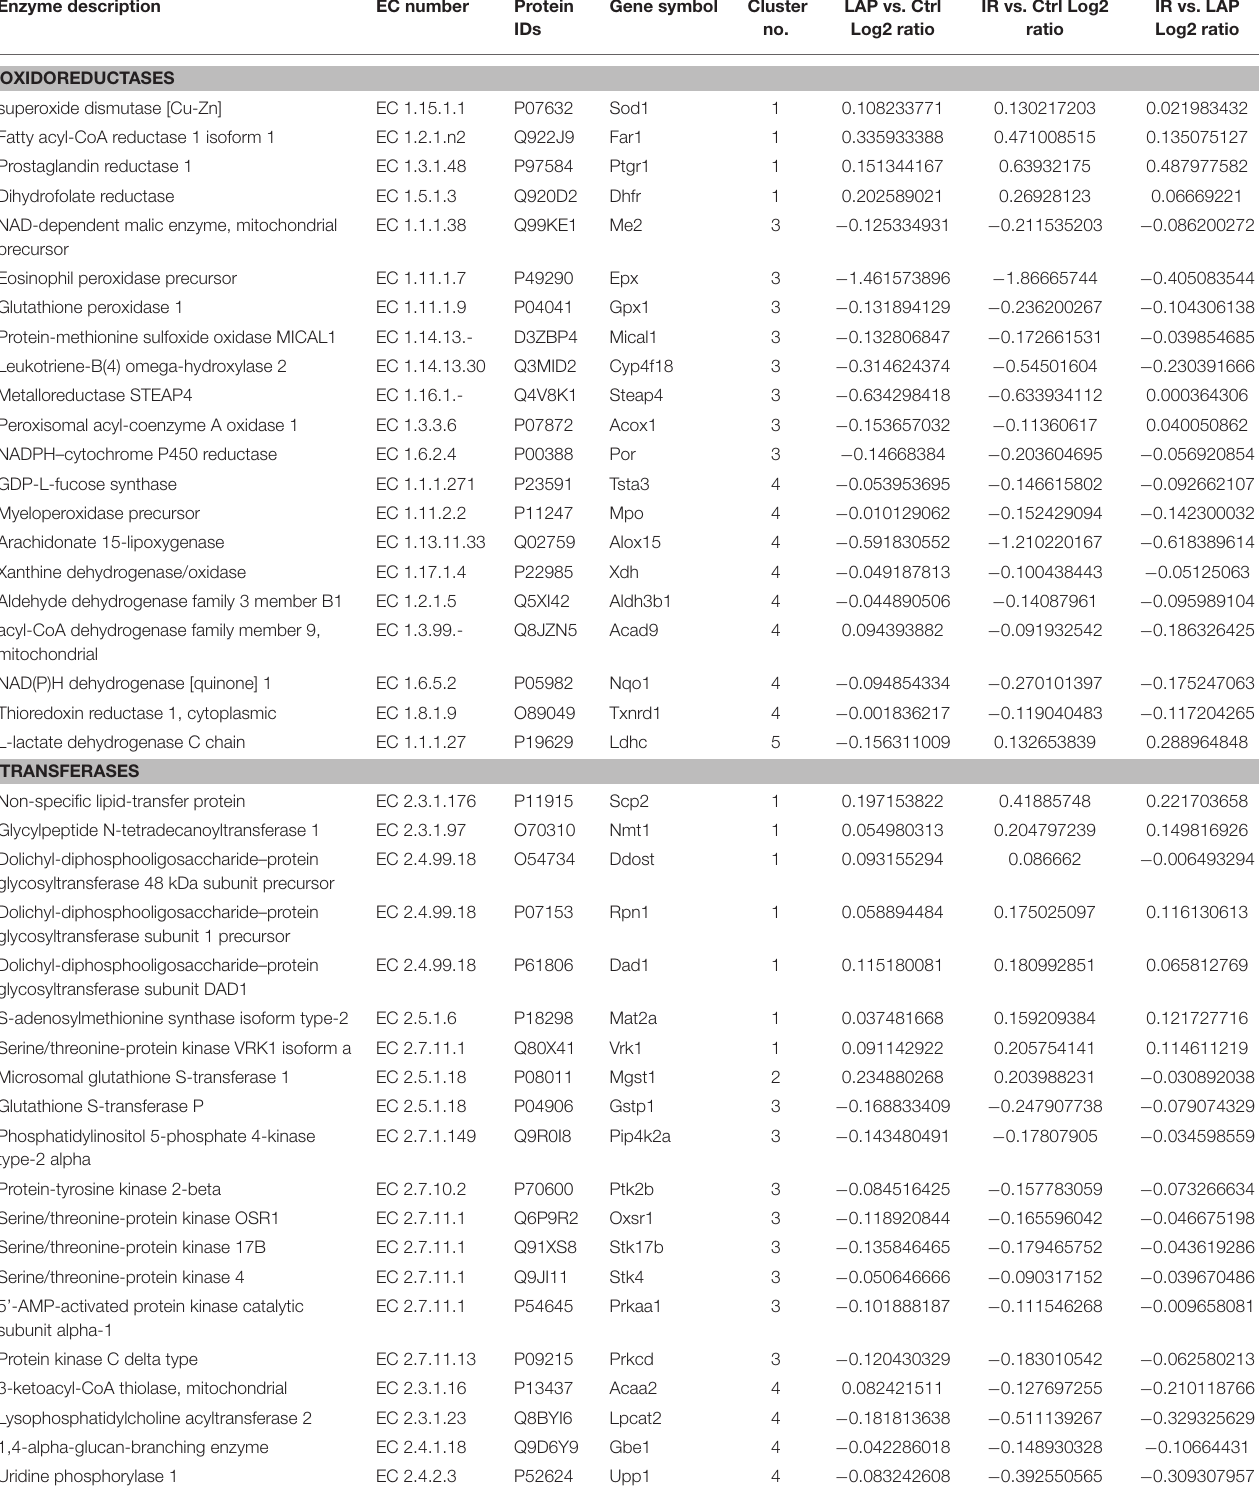
TABLE 1 | Enzyme activities prediction for the significantly regulated proteins. Enzyme description EC number Protein